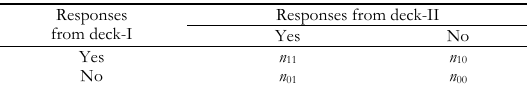
Classification of the responses from deck-I and